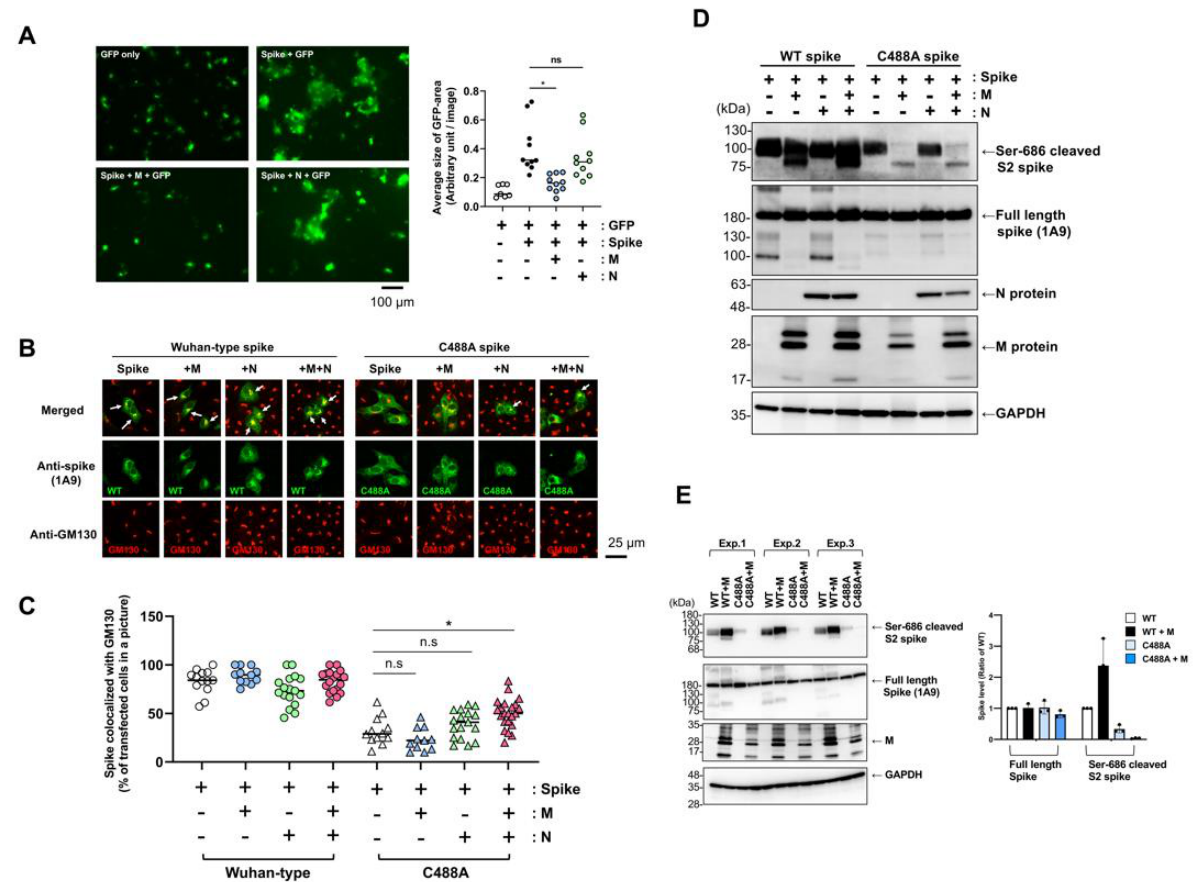
Figure 4. M protein did not affect C488A-mutant spike. ( A ) VeroE6/TMPRSS2 cells were co- transfected with spike-, M-, N-expressing plasmids with pEGFP-C1. The cells were fixed at 20 h post-transfection, and the green fluorescence protein (GFP) signals were photographed with conven- tional fluorescence microscopy. Areas of GFP-positive green cells were measured in each picture by ImageJ software, and average area size of GFP-positive cells in a picture was plotted in the right graph. One-way ANOVA with Tukey-HSD was performed to assess statistical significance. n.s. means “not significant”, and * indicates p < 0.01. ( B ) Spike-expressing plasmids were co-transfected with SARS-CoV-2 M or N protein-expressing plasmid in Vero cells, which were fixed and permeabilized. Co-localization of spikes (green) with GM130 (red) were analyzed by confocal microscopy. White arrows indicate complete co-localization (yellow) of spikes with GM130. ( C ) Co-localization of spikes and GM130 was examined in the transfected cells ( n ≥ 156), and the ratio of co-localization is shown. One-way ANOVA with Tukey-HSD was performed to assess statistical significance. n.s. means “not significant”, and * indicates p < 0.01. ( D , E ) SARS-CoV-2 spike-expressing plasmid was co-transfected with M- or N-expressing plasmid in HEK293T cells. The cell lysate was prepared after 20 h, and full-length and Ser-686 cleaved spike proteins were detected by Western blotting with anti-spike (1A9) and cleaved SARS-CoV-2 spike (Ser686) antibodies, respectively. Triplicated transfected samples were analyzed (Exp. 1–3), and signal intensity was quantified by ImageJ (right graph in E